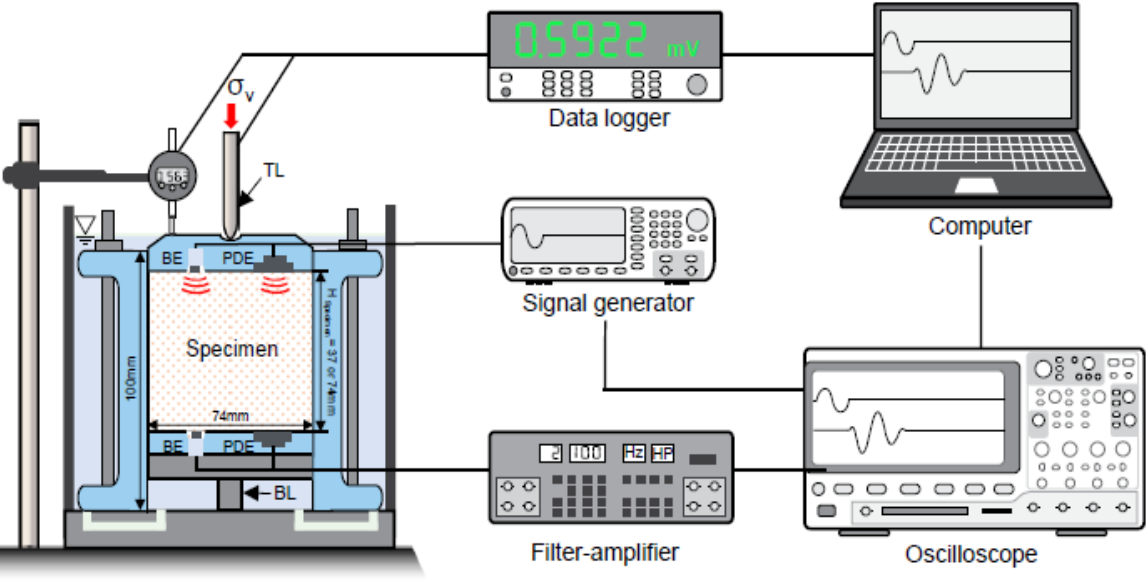
Figure 17. Schematic drawing of a modified odometric cell with electronics. TL and BL denote the load cells installed at the top and bottom plates, respectively. In addition, BE and PDE denote the bender elements and piezo-disk elements (after [71], in accordance with 2021 Creative Common CC BY License of MDPI).